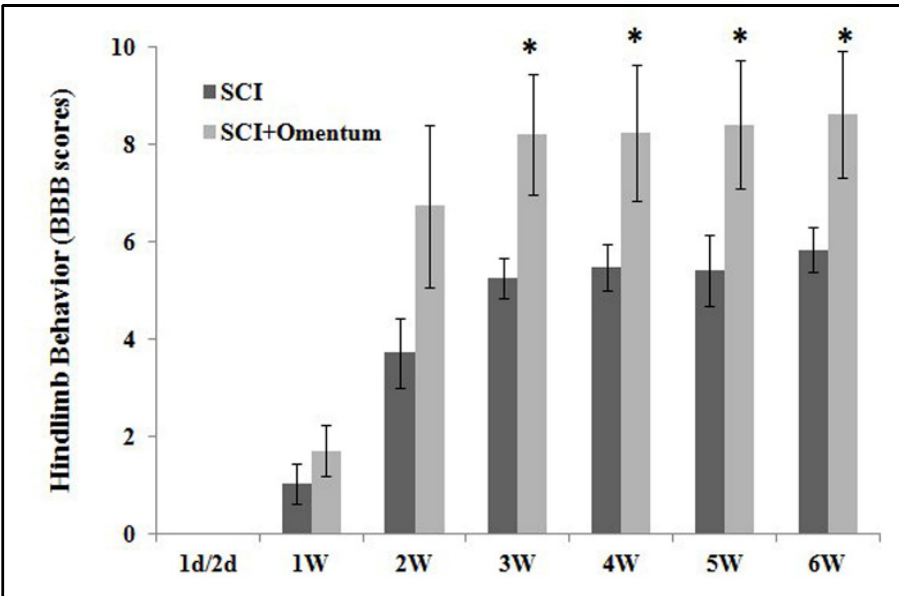
Figure 1. Identification of the rat omentum. ( A ) Laminin-immunoreactive omentum in situ; Scale bar = 100 µ m; × 200; ( B ) RECA-1-immuoreactive omentum in situ; ( C ) double-labeling RECA-1 (red)/Laminin (green)-immunoreactive omentum (superimposed photos from A , B ); ( D ) Trimmed fat tissue in dish; ( E ) Trimmed omental tissue in dish; ( F ) Properties of trimmed fat or omentum were suspended in PBS after centrifugation.